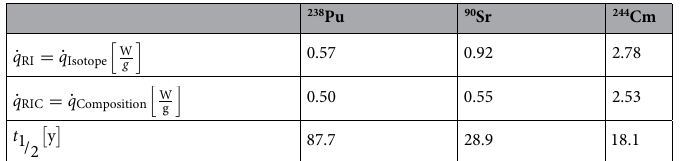
Table 6. Weight-specific thermal powers of the presented radioisotopes and their compounds. A 100% radioisotopic purity is assumed.